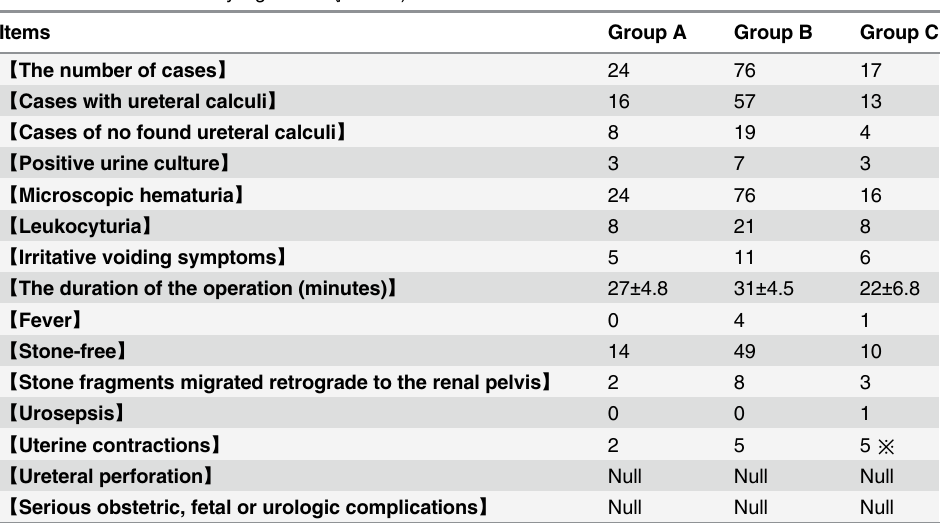
Table 1. Summary of main clinical characteristics and surgical information about persistent renal colic patients during pregnancy. Group A: patients who experienced refractory renal colic for 12 or